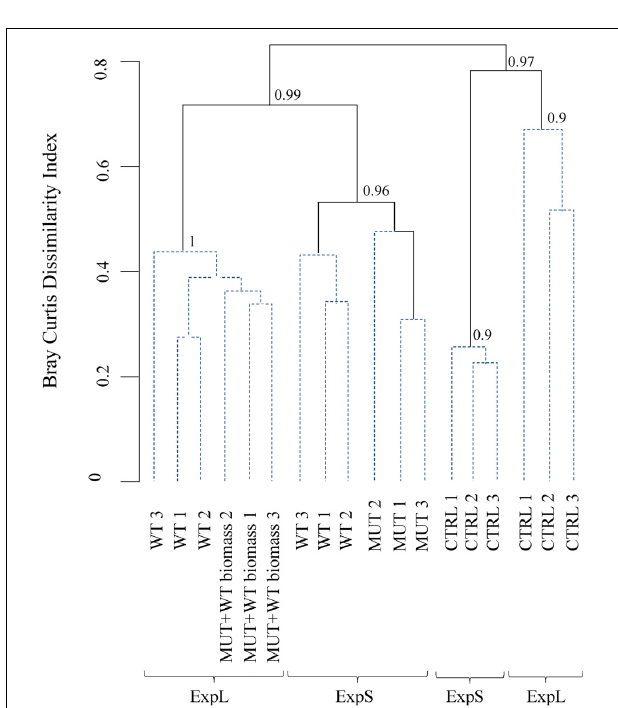
FIGURE 4 | Clustering of microbial communities from both experiments according to Bray–Curtis dissimilarity. Similarity profile analysis identified five significantly different groups (solid lines). Biological replicates were not significant different ( α = 0.001, dashed lines) from each other. The cluster stability was tested by bootstrapping (1000 times interaction); bootstrap values are indicated at the branching points.